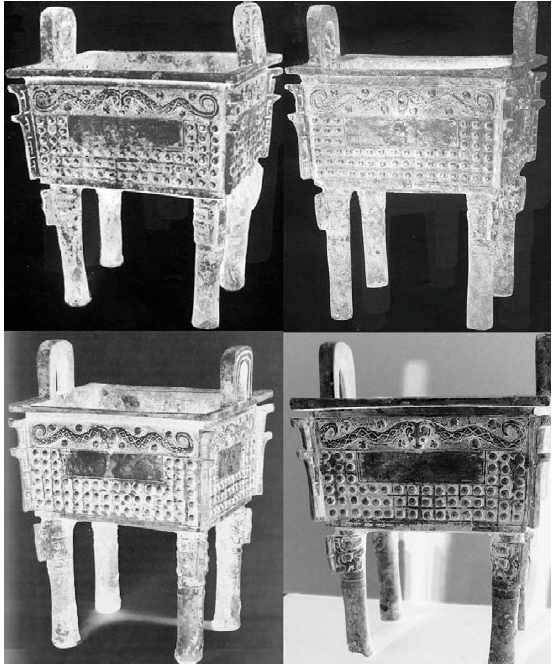
Figure 5. Four identical Zuoce Da small tetrapod ding preserved at the Royal Palace Museum, Taiwan (two in the top row), Freer Gallery of Art, Washington, D.C. (lower left), and the Hermitage Foundation Museum, Norfolk, Virginia (lower right). Sources: Ku-kung 1958 vol. 2: pls. 62–63 (top row); Pope 1967 vol. 1: pl. 195 (lower right); and courtesy of the Hermitage Museum and Gardens, Sloane Collection, Norfolk, Virginia, 50-G-11 (lower left).